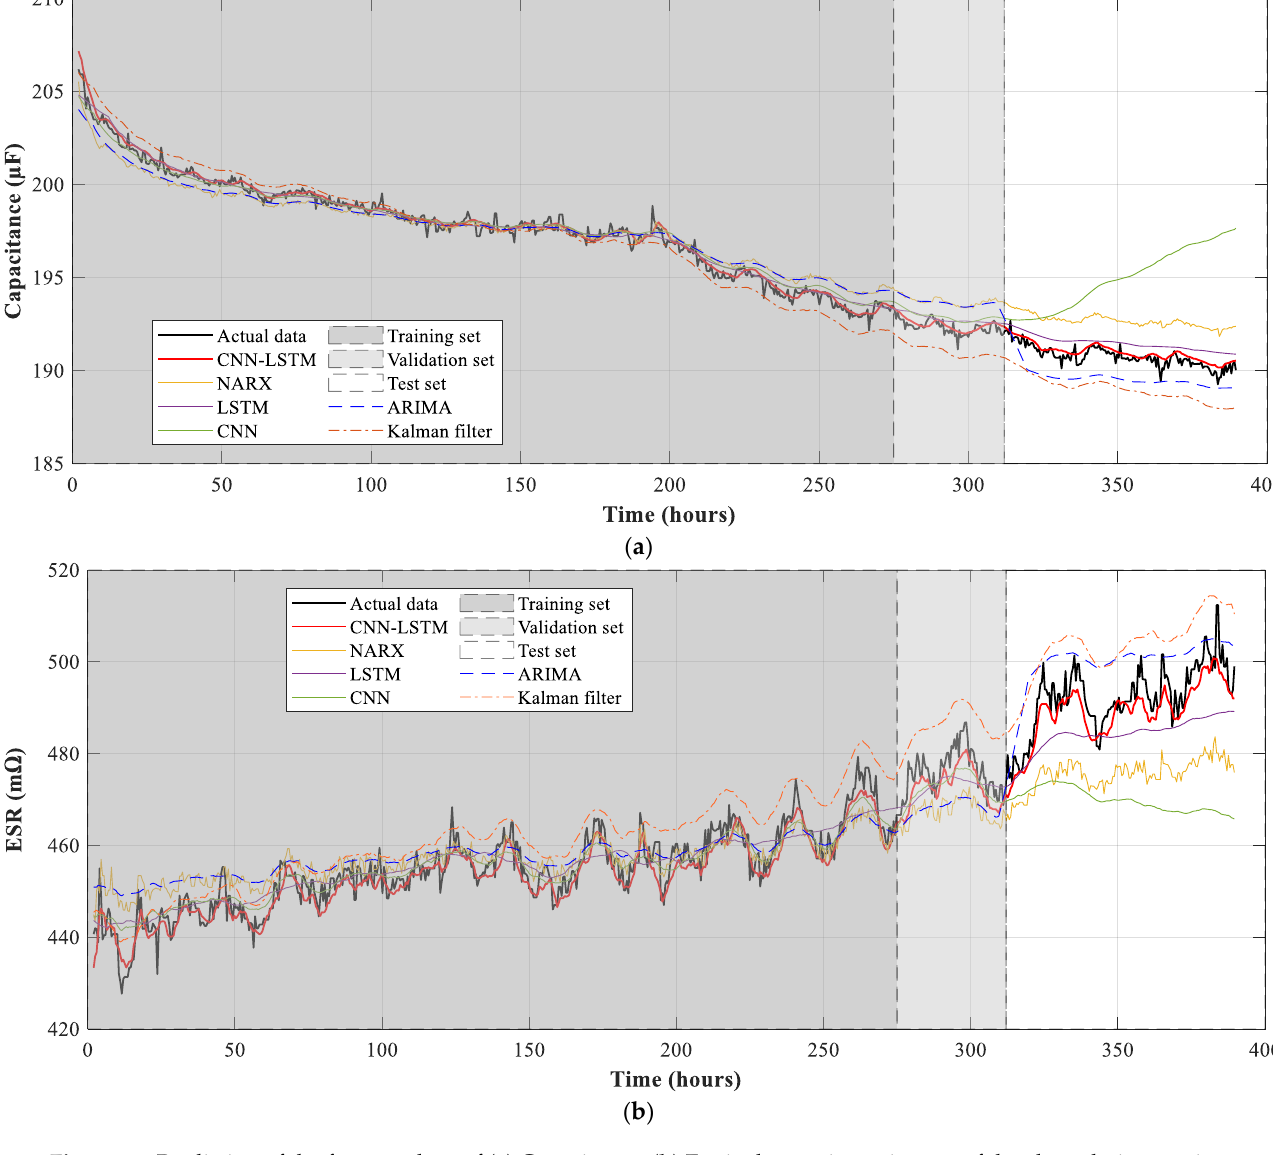
Figure 12. Prediction of the future values of ( a ) Capacitance; ( b ) Equivalent series resistance of the electrolytic capacitor. Table 2. CNN-LSTM performance and comparison with other methods.